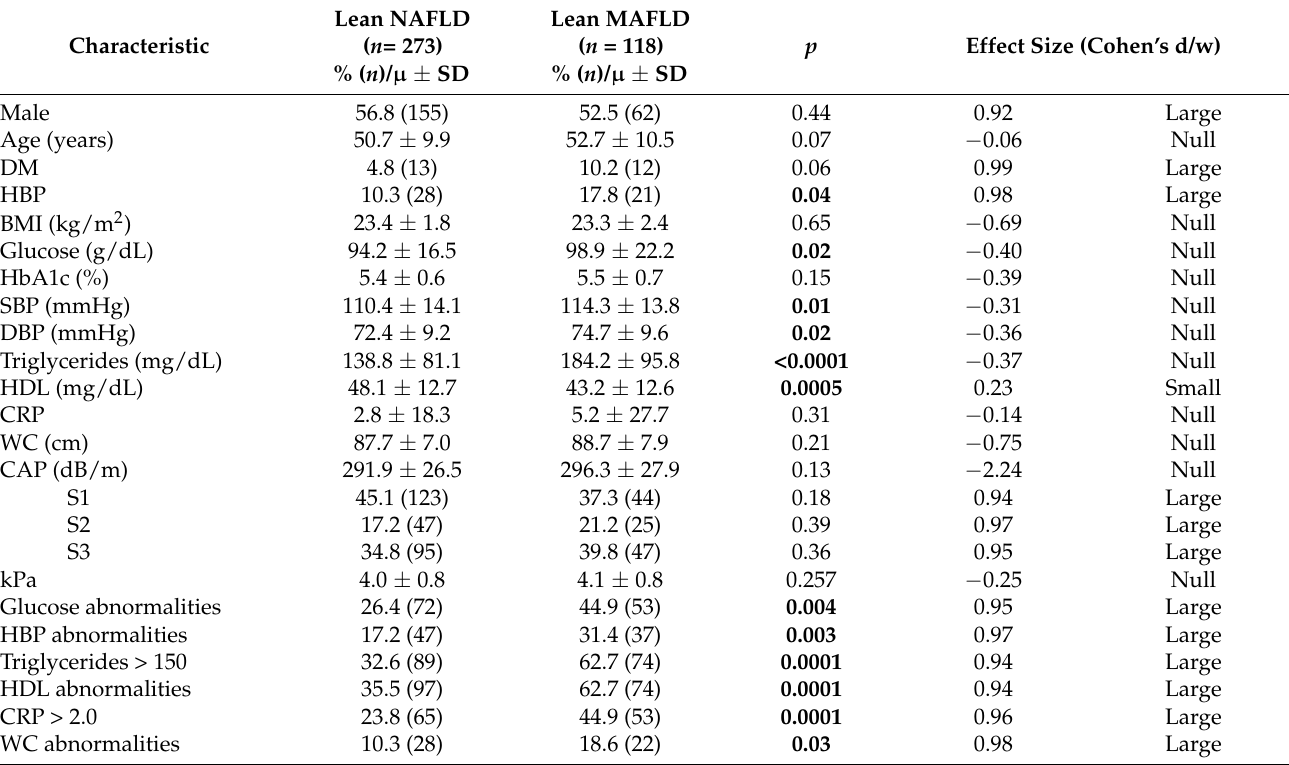
Table 3. Differences in clinical and demographic characteristics of NAFLD and MAFLD criteria in patients with BMI < 25 kg/m 2 .